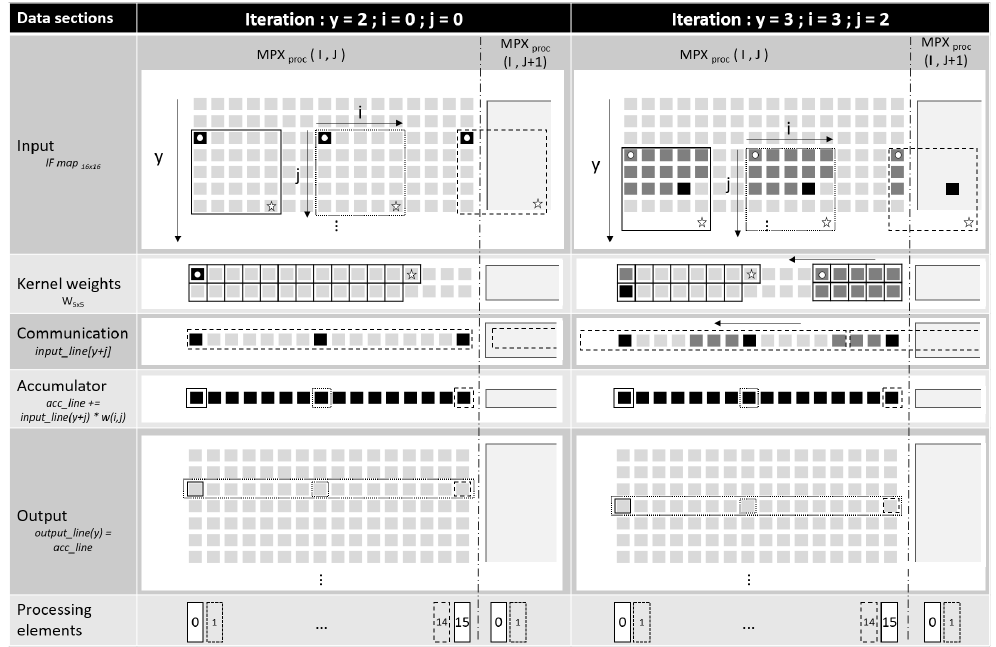
Figure 5. Convolutional kernel implementation in a MPX-p. Two example states of a 5 × 5 kernel convolution at y = 2; i = 0; j = 0 and y = 3; i = 3; j = 2. Input, kernel weights, communication, accumulator and output data section are represented as rows of a table. An additional bottom row shows the PEs that operate on the columns of data in the register file. Each grey or black square corresponds to a data stored in the register file. Black squares identify the current data in use by a processing element and dark grey squares show data already processed on the current Y iteration by the kernel. White circles and stars in the input and weights sections mark the start and end points of the